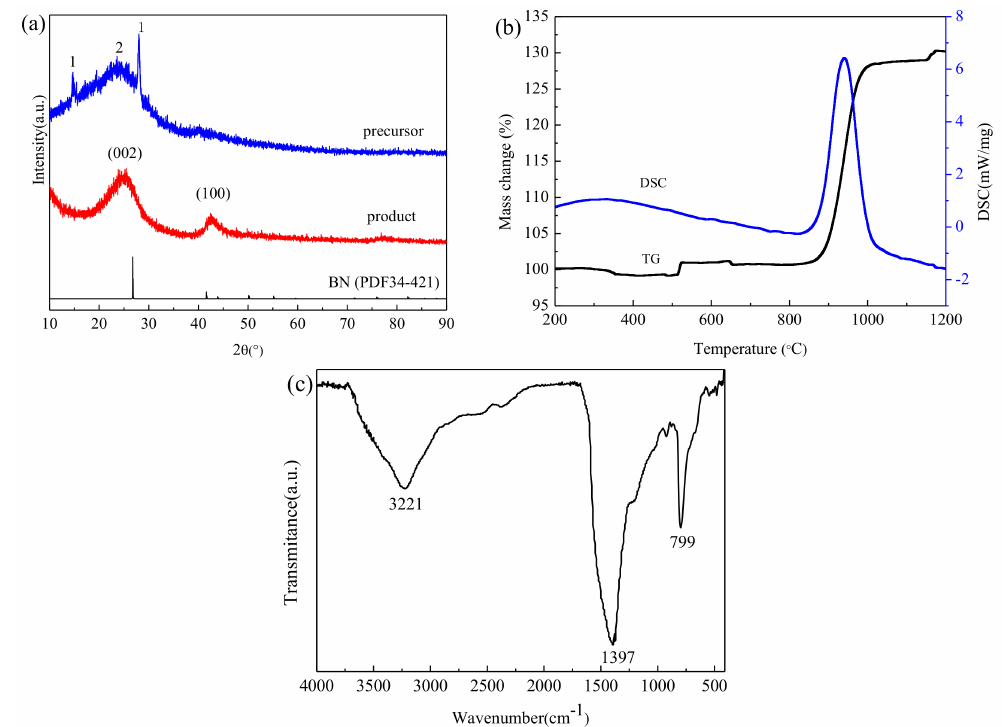
Figure 1. XRD pattern ( a ) of the precursor and the BN sample and the black vertical lines indicate the peak positions of the BN (PDF34-421) reflections. TG-DSC ( b ) and FIRT spectrum ( c ) of the BN.